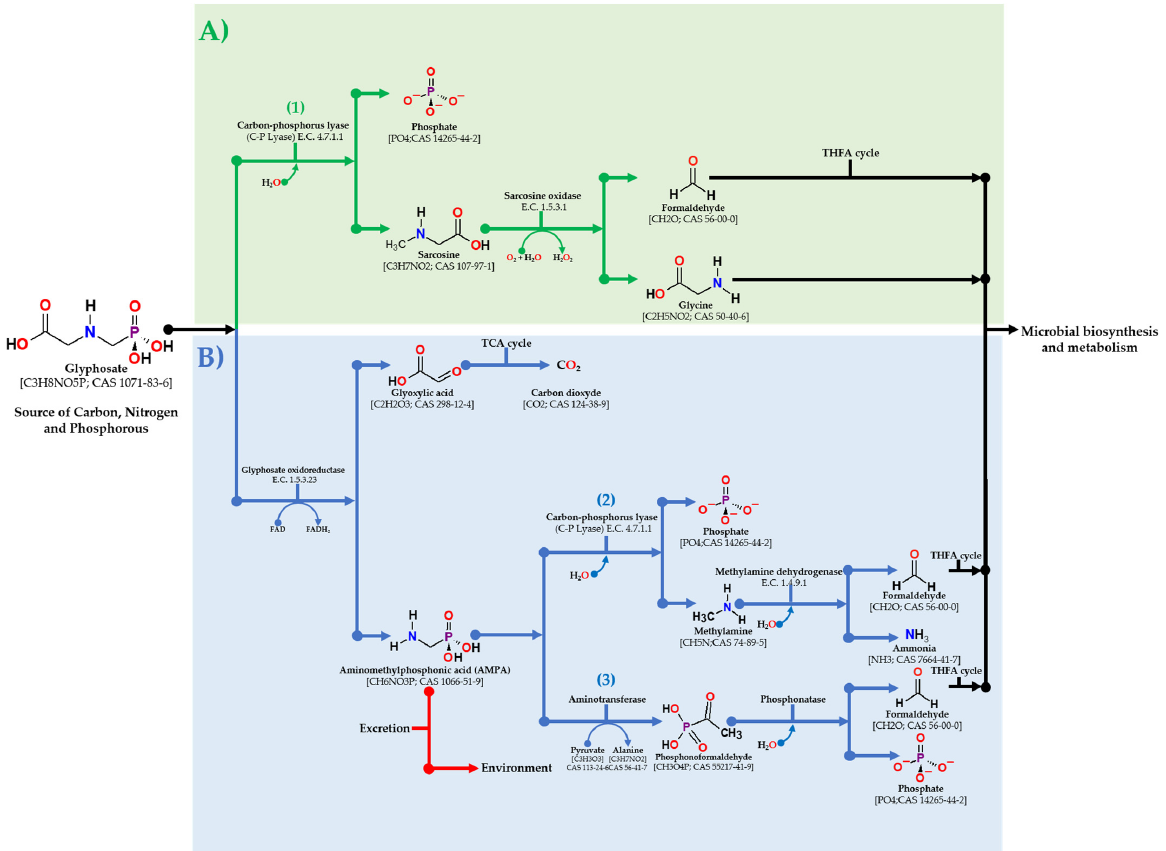
Figure 2. Principal glyphosate biodegradation pathways in bacteria. ( A ) Carbon-phosphorous lyase pathway (C-P lyase), (1) glyphosate degradation through sarcosine release as reported in Pseudomonas sp. PG2982 [149]. ( B ) Glyphosate oxidoreductase pathway (GOX pathway), (2) AMPA degradation in methylamine as reported in Arthrobacter sp. GLP-1 [150] and Flavobacterium sp. GD1 [151], and (3) alternative AMPA degradation pathway through the aminotransferase activity as reported in Ochrobactrum anthropi [152].